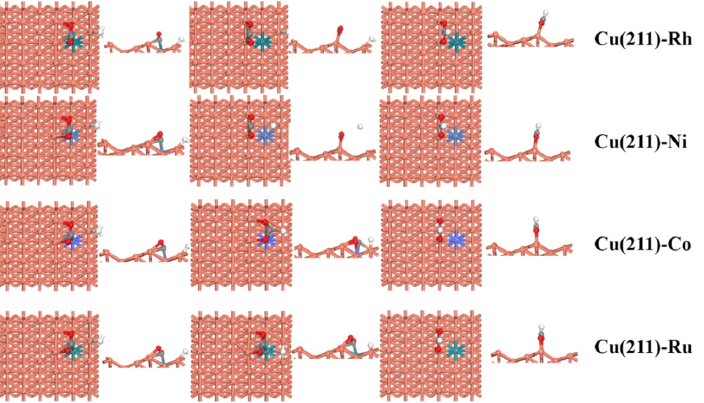
Figure 4. Top and side views of the initial state (IS), transition state (TS), and fi nal state (FS) for CO 2 activation via HCOO intermediate on the pure and transition-metal-doped Cu(211)-M (M = Rh, Ni, Co, and Ru) surfaces.